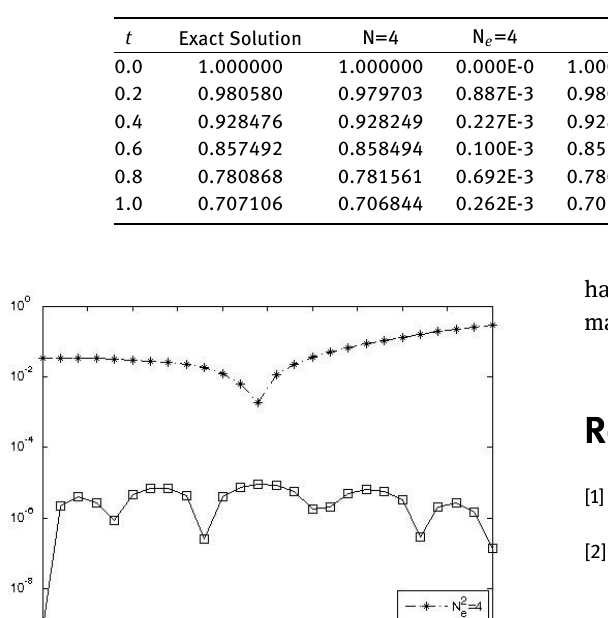
Table 5: Numerical result for approximate solution of y 2 ( t ) in Example 5.